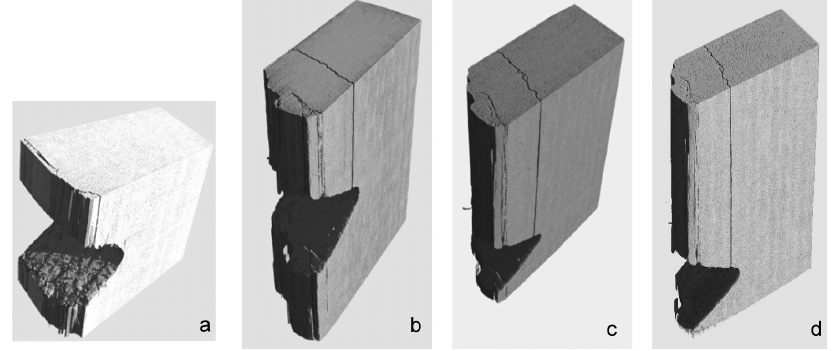
Fig. 8. Right-side view before testing (a); after 250 impacts (b); after 400 impacts and after 600 impacts (d)